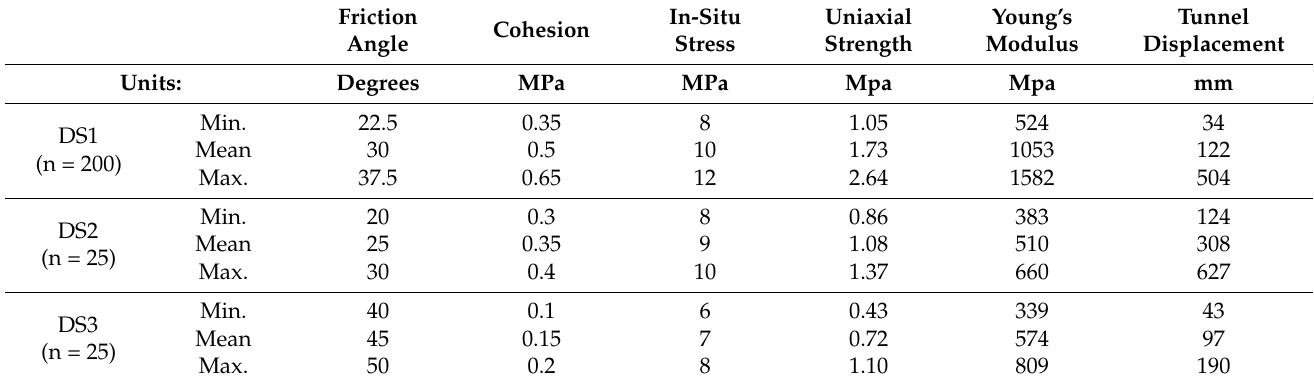
Table 1. Dataset #1 (DS1), #2 (DS2), and #3 (DS3) input parameter range and tunnel displacements computed via the CC